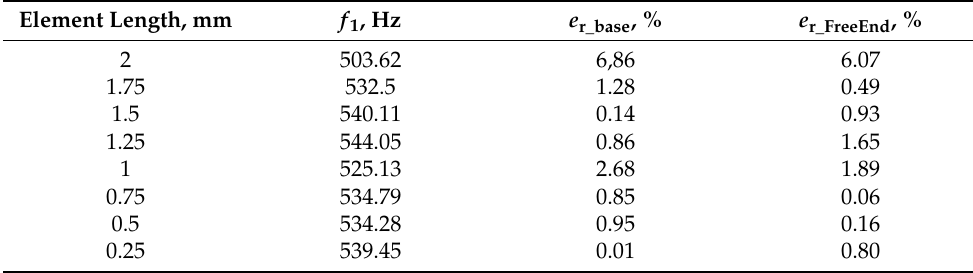
Table 4. Mesh sensitivity analysis for hexahedral (brick) elements with glued volumes.